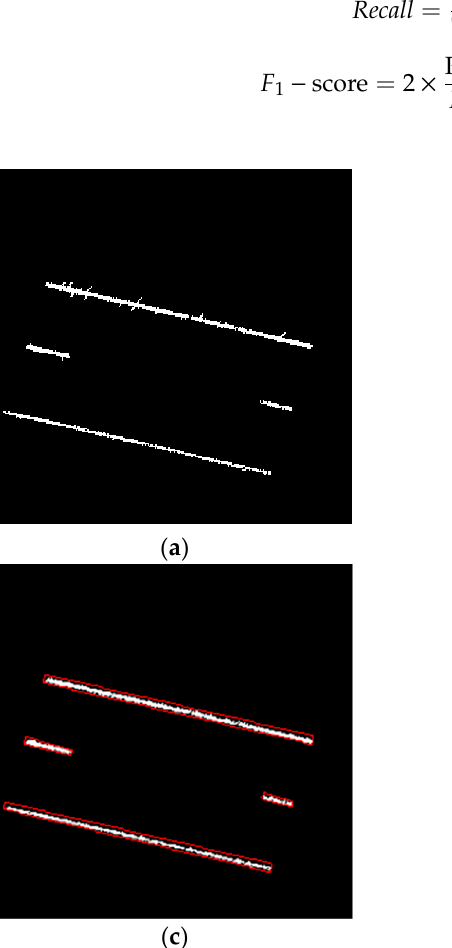
Figure 10. Illustrations of ( a ) original road surface point cloud block and ( b ) corresponding intensity image.